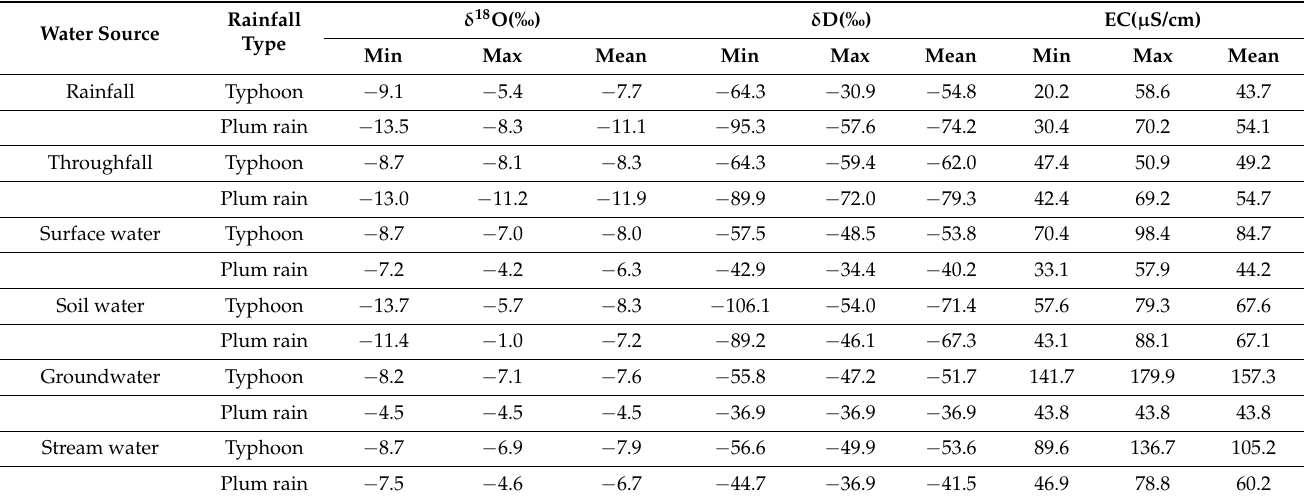
Table 1. Characteristics of stable water isotopes and EC in each hydrological compartment during the typhoon and plum rain events at the Hemuqiao